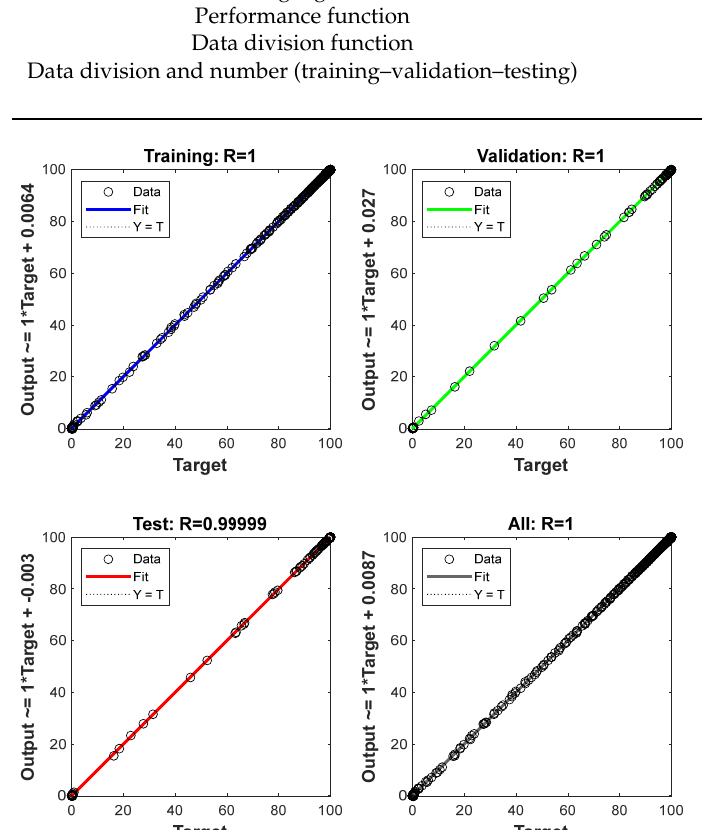
Figure 4. Regression of four plots for the final ANN .